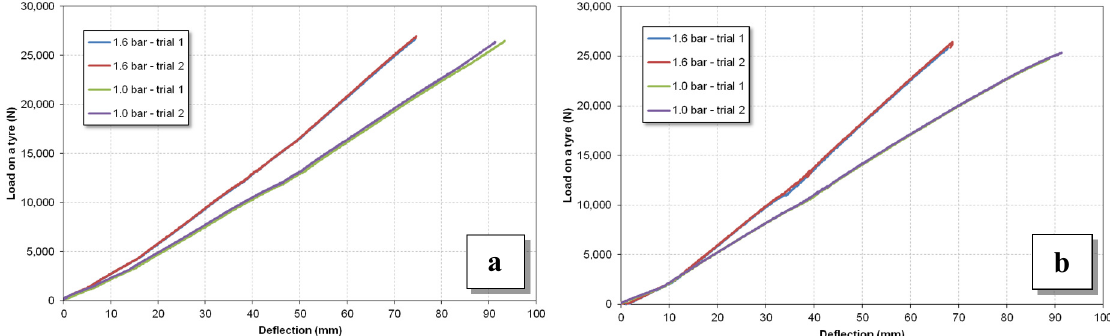
Figure 5. Experimental load–deflection curves at two different inflating pressures: ( a ) 420/85 R24 tyre; ( b ) 460/85 R34 tyre. Two trials were performed for each case.